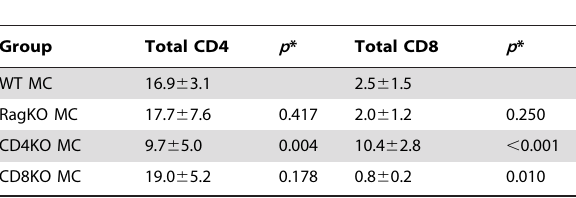
Table 3. T cell reconstitution in peripheral blood prior to DLI.